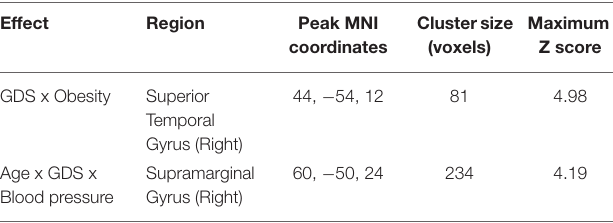
TABLE 2 | Effect of the interaction between GDS x obesity and between age x GDS x blood pressure on the default mode network FC (multiple regressions, cluster correction, p <